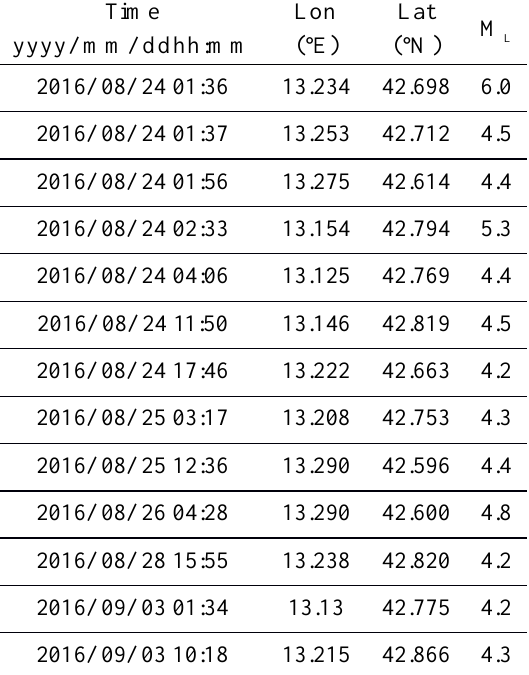
Table II: Mainshock and aftershocks occurred during the 2016 Amatrice sequence (24/08/2016- 18/09/2016). The time is reported in